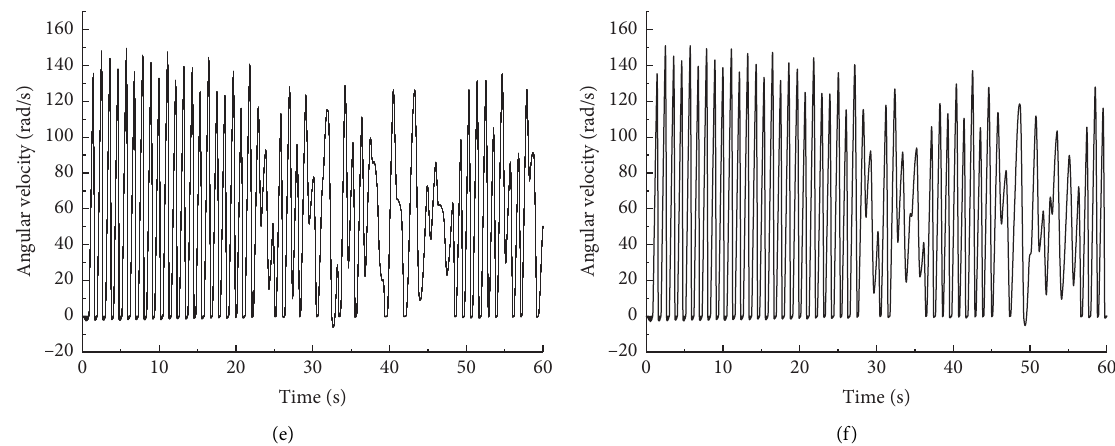
Figure 8: Angular velocity for various axial forces: (a) 44.5kN, (b) 98 kN, (c) 133.5kN, (d) 178kN, (e) 222.5kN, and (f) 267 kN.